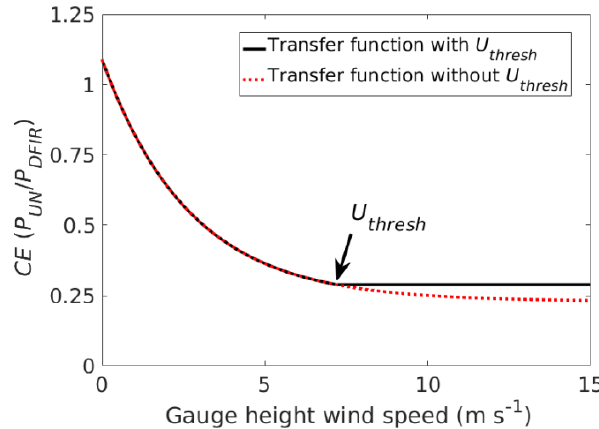
Figure 3. Example application of the maximum wind speed thresh- old ( U thresh ) , using an Eq. (2) type transfer function describing unshielded (UN) solid precipitation catch efficiency (CE) from K2017a. At wind speeds exceeding U thresh (7.2ms − 1 in this case) the catch efficiency is fixed at the value determined at U thresh